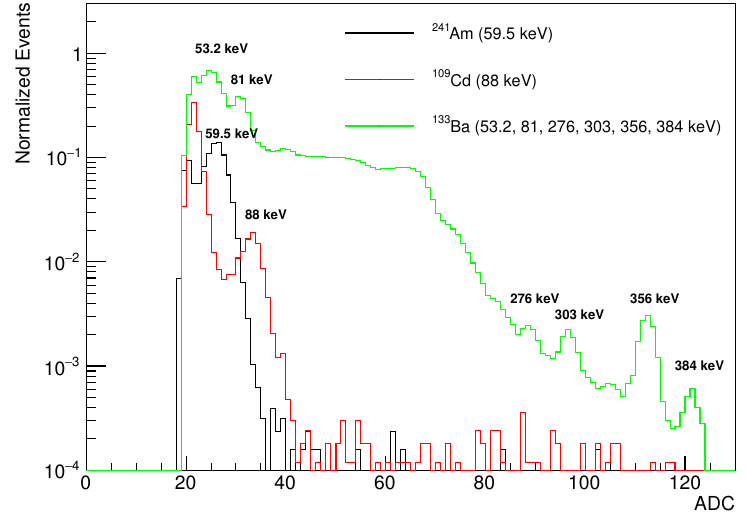
Figure 6. Measured Pulse Height Spectra in High Gain Mode With a Set of Low-and Medium-energy Gamma Rays from Radioactive Gamma